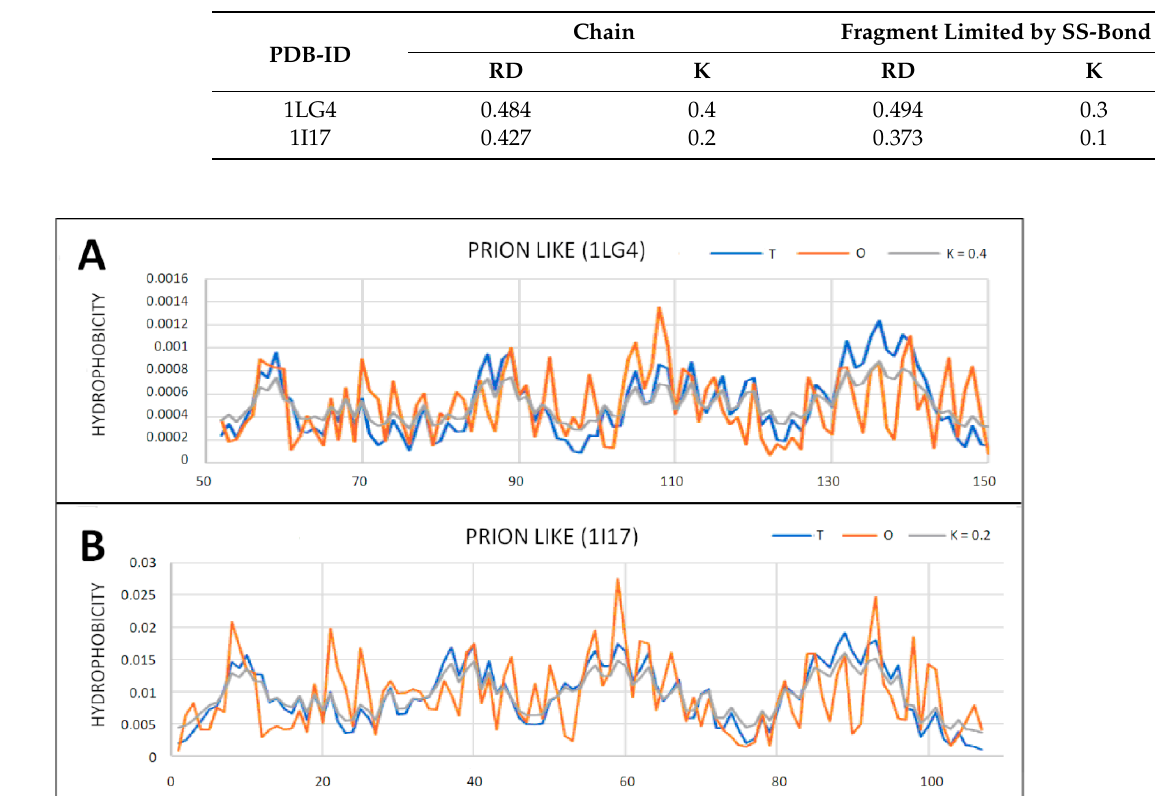
Figure 10. T, O and M profiles for prion-like proteins. ( A ) Protein with the code PDB—1LG4; ( B ) protein with the code PDB—1I17.